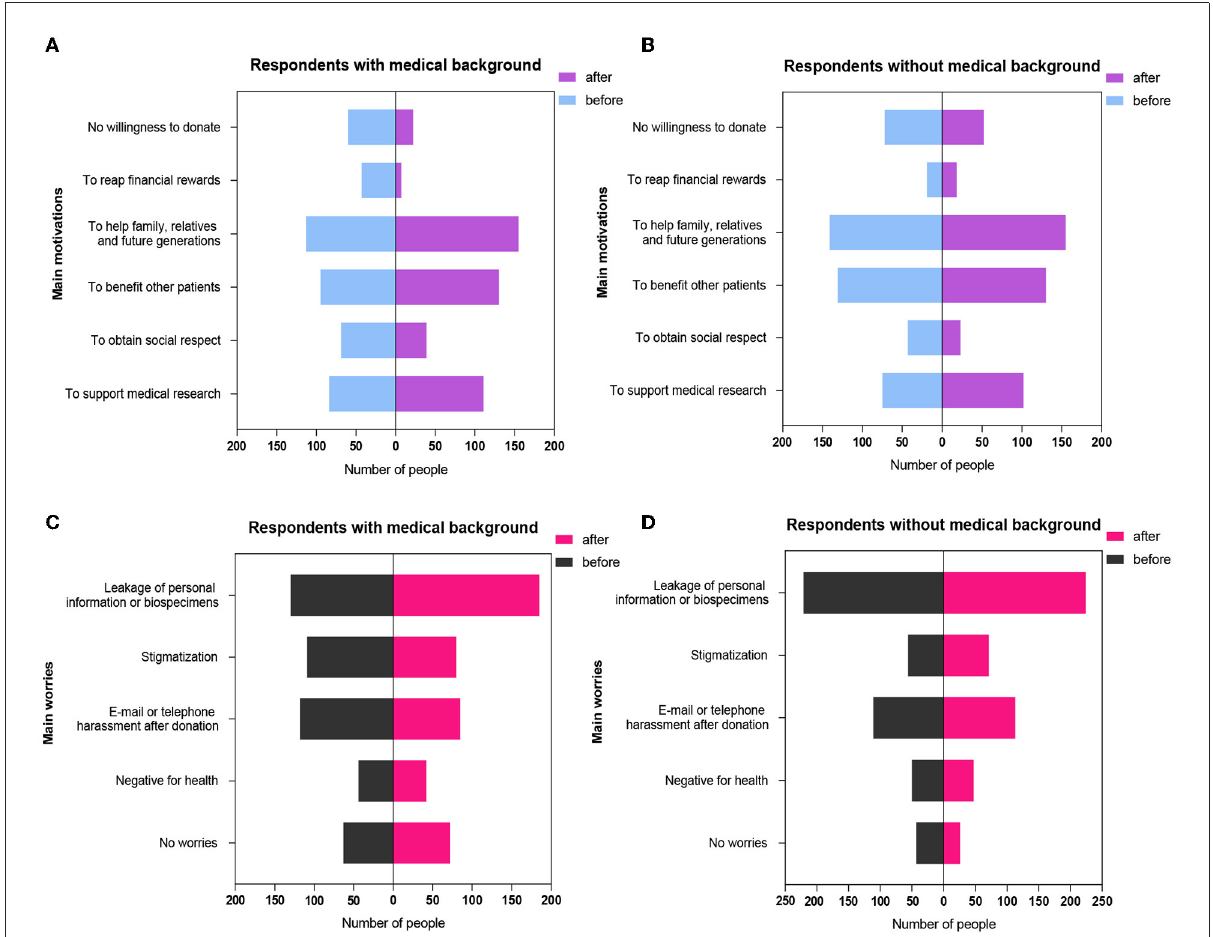
FIGURE2 The changes in main motivations and concerns of respondents about sample donation before and after publicity. (A) The changes in motivations toward sample donation among respondents with medical background before and after publicity. (B) The changes in motivations toward sample donation among respondents without medical background before and after publicity. (C) The changes in concerns about sample donation among respondents with medical background before and after publicity. (D) The changes in concerns about sample donation among respondents without medical background before and after